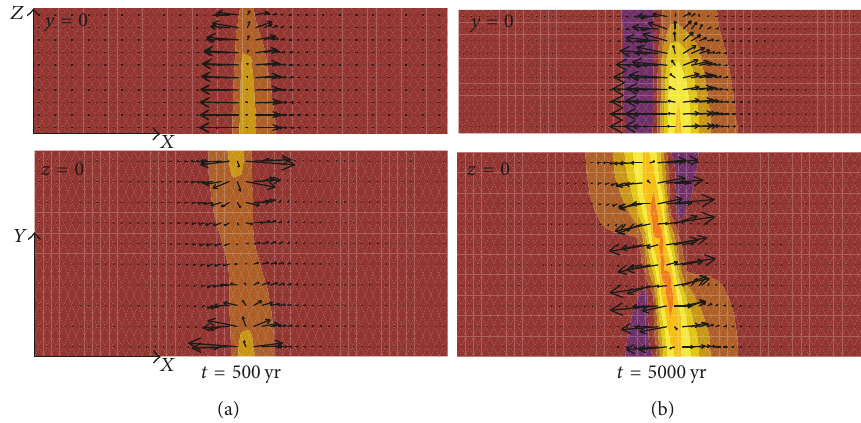
Figure 5: The flow direction in two cross sections ( 𝑌 = 0 and 𝑍 = 0 ) of Model I at 𝑡 = 500 yr and 5000 yr.